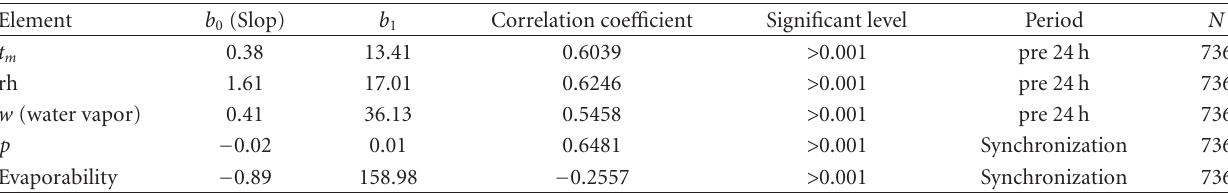
Table 1: Correlation analyses for PM 10 with meteorological elements x i